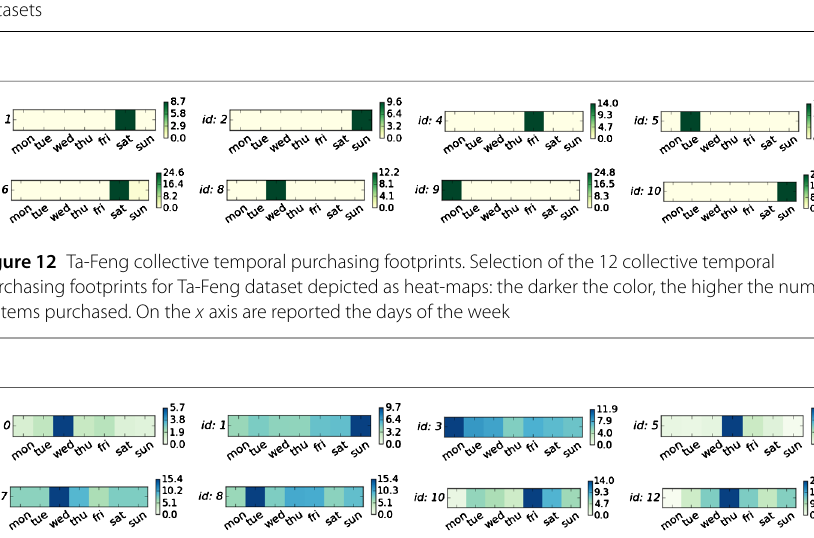
Figure 11 Ta-Feng and T-Mall collective footprints analysis. Distributions of customers per number of individual footprints (left) and number of collective footprints (right), for Ta-Feng (top) and T-Mall (bottom) datasets